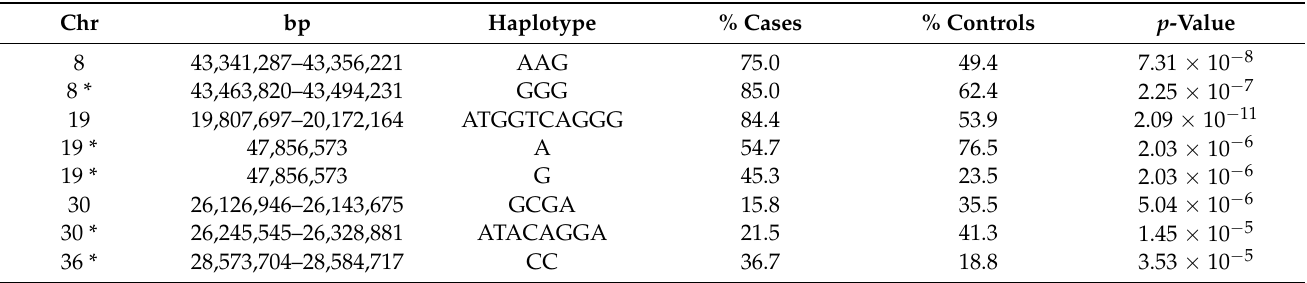
Table 6. Haplotypes for chromosomes revealed by the case/control and quantitative GWAS and subsequent haplotype analysis. For each chromosome we show the most significant haplotype and a haplotype containing the most significant or suggestive SNP for each chromosome (marked by